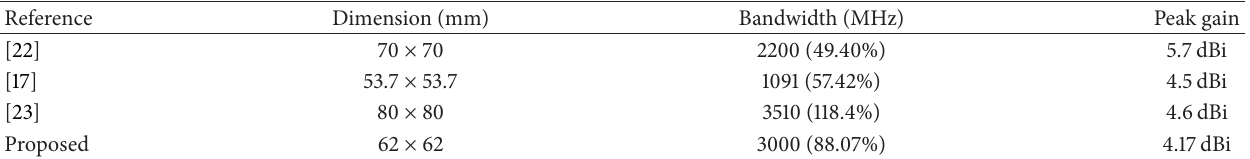
Table 3: Comparison between proposed and some existing